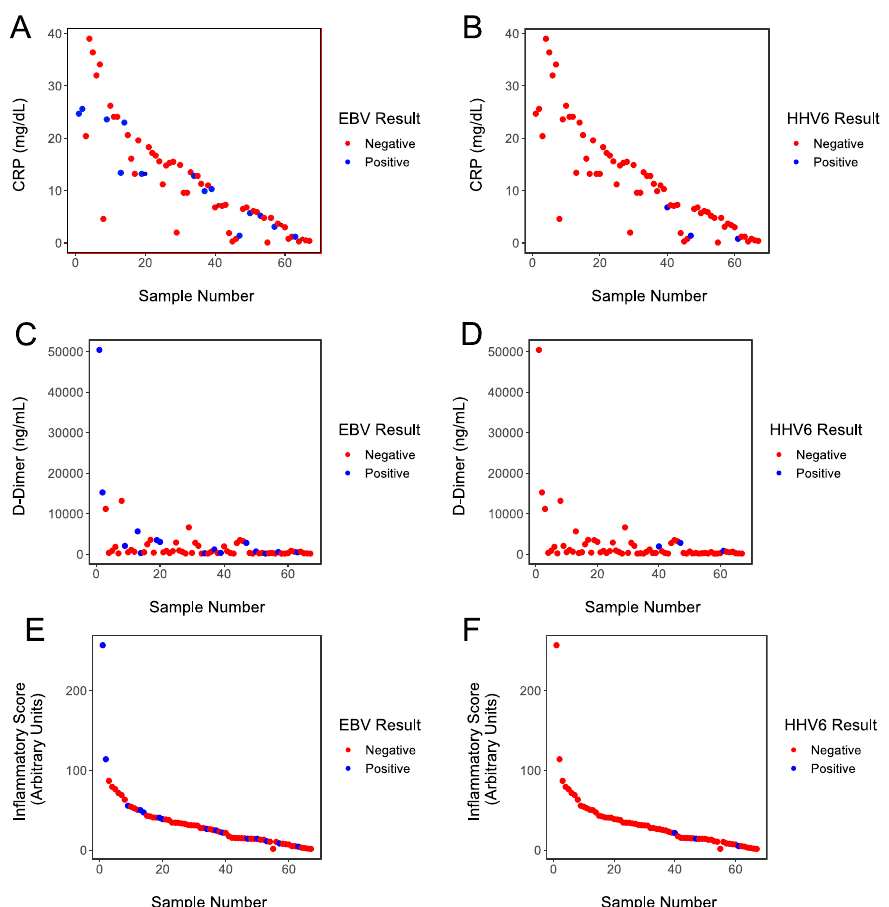
Figure 3. ( A ) CRP values plotted for each study participant. Values for patients with negative EBV assays are indicated in red and values for patients with positive EBV assays are indicated in blue. ( B ) CRP values plotted for each study participant. Values for patients with negative HHV-6 assays are indicated in red and values for patients with positive HHV-6 assays are indicated in blue. ( C ) D-Dimer values plotted for each study participant. Values for patients with negative EBV assays are indicated in red and values for patients with positive EBV assays are indicated in blue. ( D ) D-Dimer values plotted for each study participant. Values for patients with negative HHV-6 assays are indicated in red and values for patients with positive HHV-6 assays are indicated in blue. ( E ) CIS values plotted for each study participant. Values for patients with negative EBV assays are indicated in red and values for patients with positive EBV assays are indicated in blue. ( F ) CIS values plotted for each study participant. Values for patients with negative HHV-6 assays are indicated in red and values for patients with positive HHV-6 assays are indicated in blue. For visualization purposes, to highlight any possible associations between inflammatory state and virus reactivation, the samples were first ranked by CIS prior to drawing the figures.